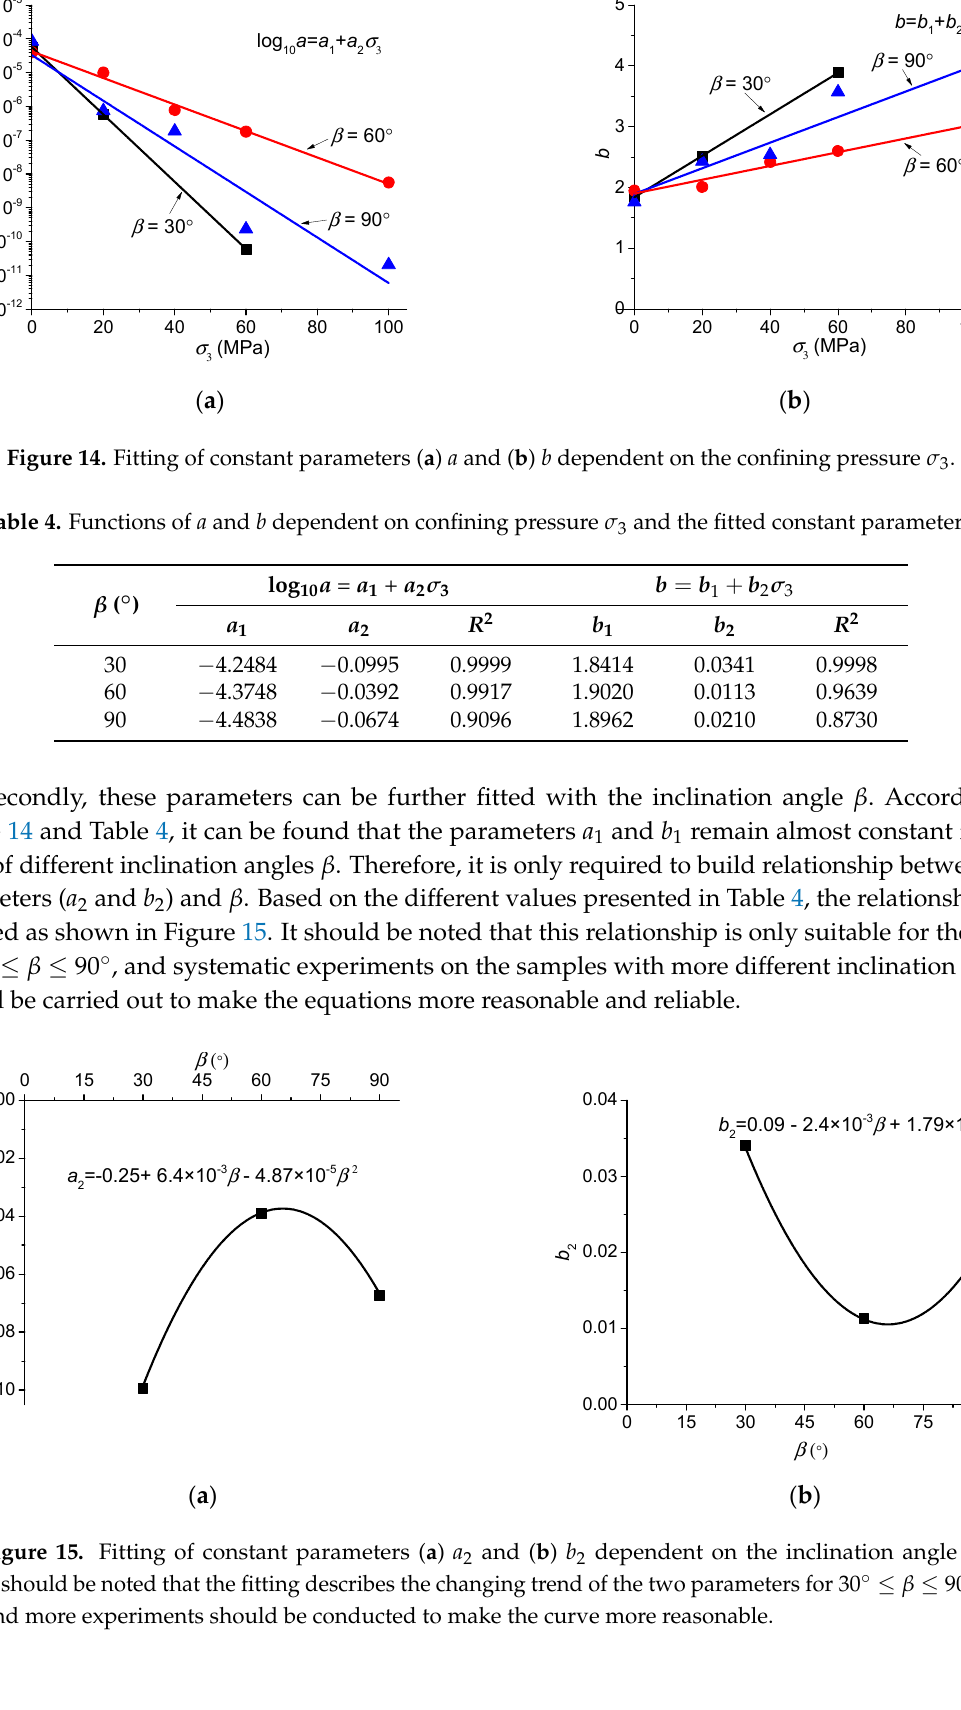
and more experiments should be conducted to make the curve more reasonable.